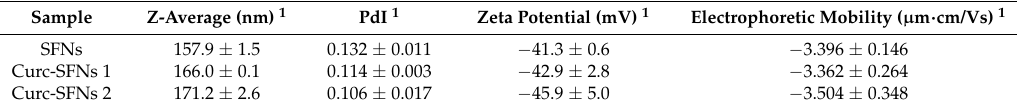
Table 1. Physical characterization of the silk fibroin nanoparticles (SFNs), curcumin-loaded silk fibroin nanoparticles synthesized by physical adsorption (Curc-SFNs 1) and curcumin-loaded silk fibroin nanoparticles synthesized by coprecipitation (Curc-SFNs 2).